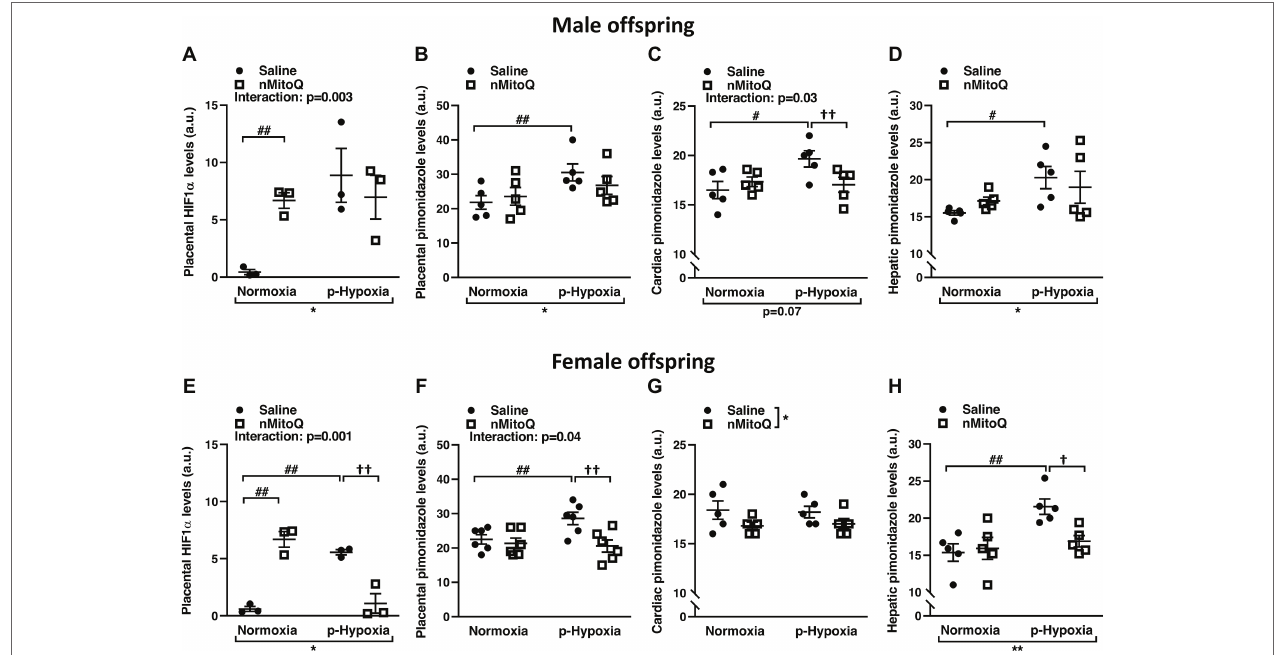
FIGURE 2 | Effects of nMitoQ treatment on placental and fetal hypoxia. Expression of HIF1- α protein, a marker for tissue hypoxia in placentae obtained from male (A) and female (E) fetuses on GD21. Oxygenation levels as assessed by pimonidazole staining in the placentae of male (B) and female (F) , the cardiac tissues of male ( C) and female (G) and hepatic tissues of male (D) and female (H) fetuses on GD21. Data are represented as mean ± SEM. a.u.: arbitrary units. All groups were compared using a two-way ANOVA followed by Sidak’s post hoc test ( n = 5–6/group). * p < 0.05, ** p < 0.01 group effect of prenatal hypoxia and nMitoQ treatment; # p < 0.05, ## p < 0.01 compared to normoxia-saline; † p < 0.05, †† p < 0.01 compared to hypoxia-saline